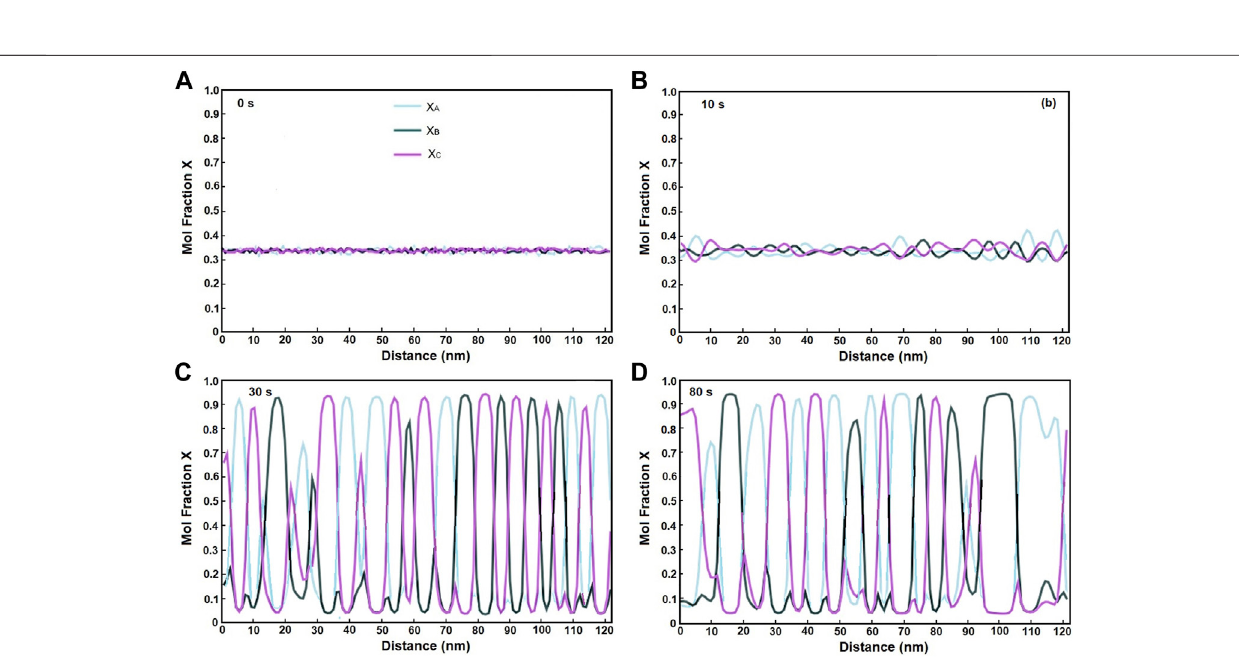
Frontiers in Materials |